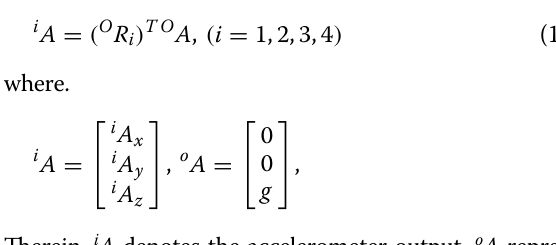
16 ± 10 Gauss). The ±